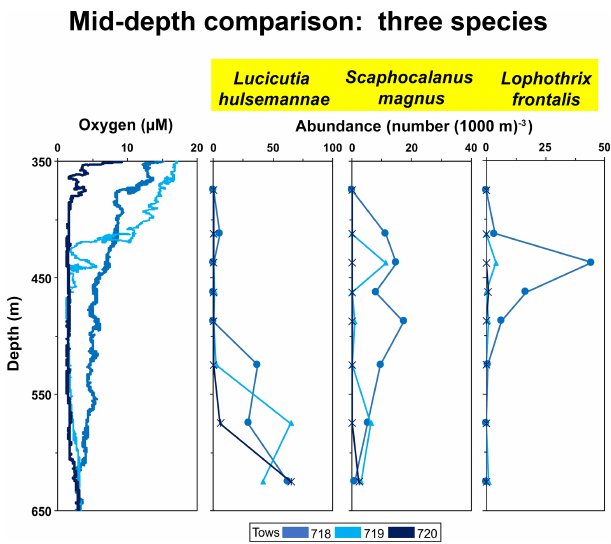
Figure 4. Vertical distributions of three species relative to oxygen for the three sequential tows (2 days, 1 night) in the mid-depth com- parison series at SKQ 17. Oxygen profiles from each tow (color coded by tow; see legend) are shown in the left graph. Species dis- tributions from each tow are color coded to match the oxygen pro- file. The depth range for these profiles is 350–650m. These species responded to the slight variations in oxygen between